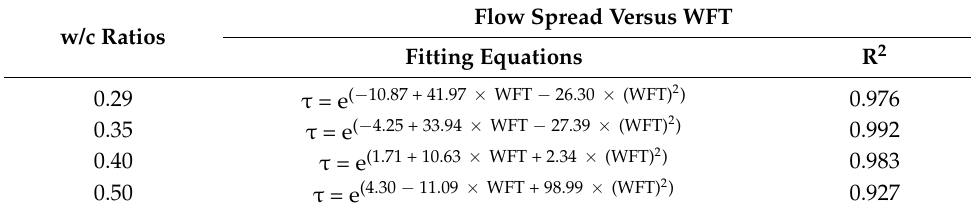
Figure 9. Flow spread versus WFT. Table 4. The fitting equations and R 2 value of flow spread versus WFT.